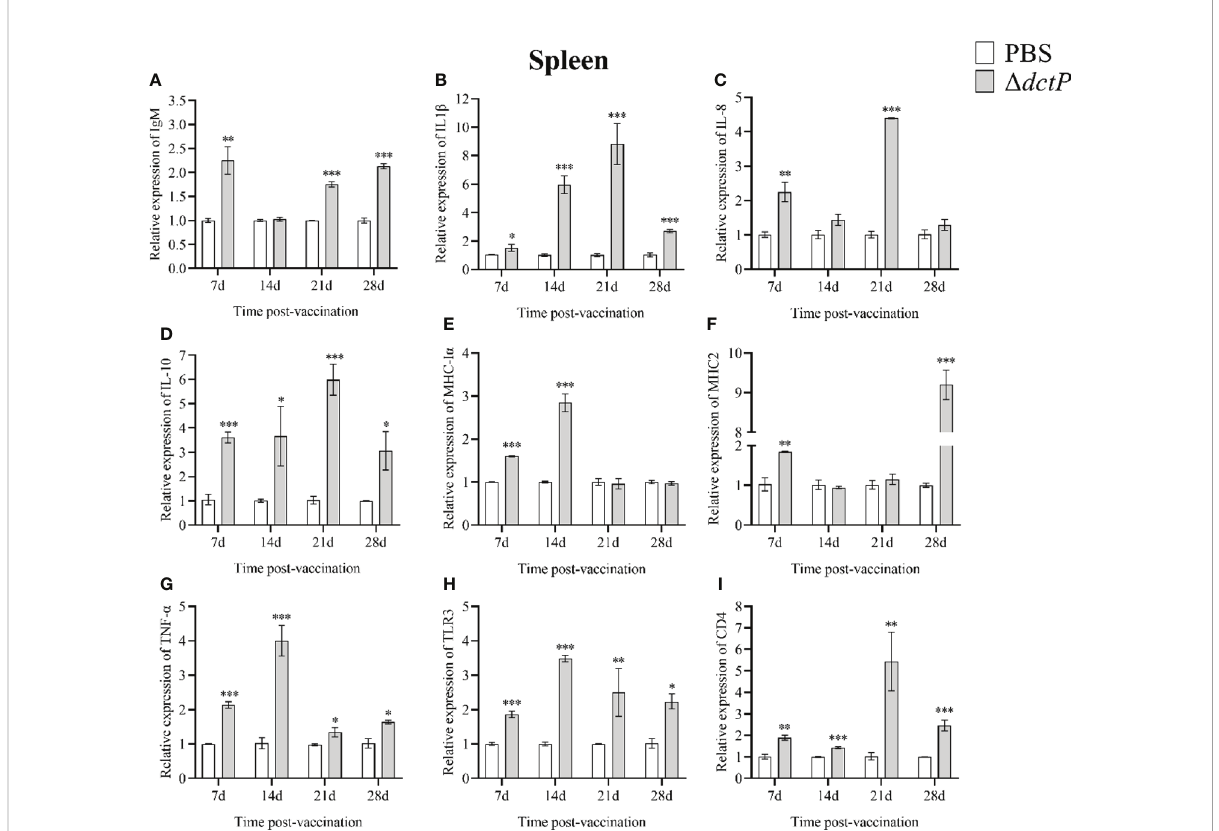
FIGURE 4 The expression levels of immune-related genes in the spleen of pearl gentian groupers by qRT-PCR post-immunization. The mRNA level of each immune-related gene was normalized to that of b -actin and relative expression was calculated as the values of the vaccinated tissues by those of the controls. (A) IgM , (B) IL-1 b , (C) IL-8 , (D) IL-10 , (E) MHC-I a , (F) MHC2 , (G) TNF- a , (H) TLR3 , and (I) CD4 . Bars represented the mean relative expression (n=3) and error bars represent standard errors. The asterisks indicated signi fi cant differences: *(p < 0.05), **(p < 0.01) and *** (p < 0.001), between PBS group and D dctP